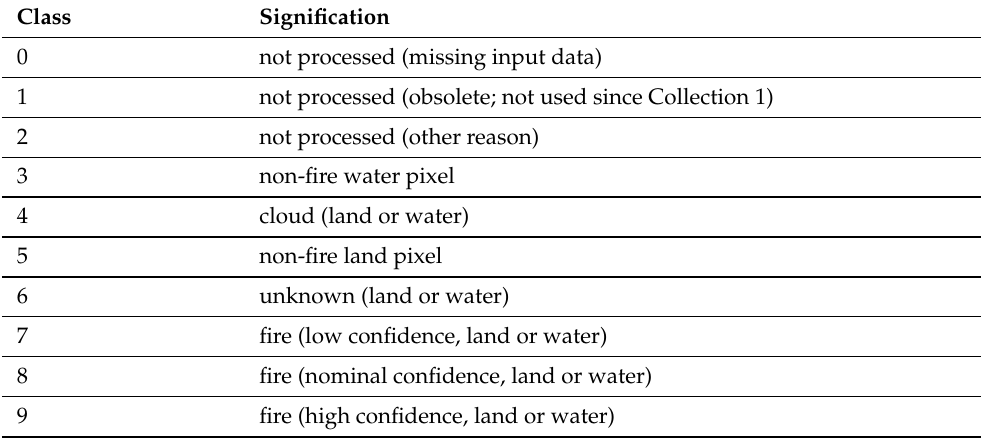
Table 1. MOD14/MYD14 fire mask pixel classes, from Giglio